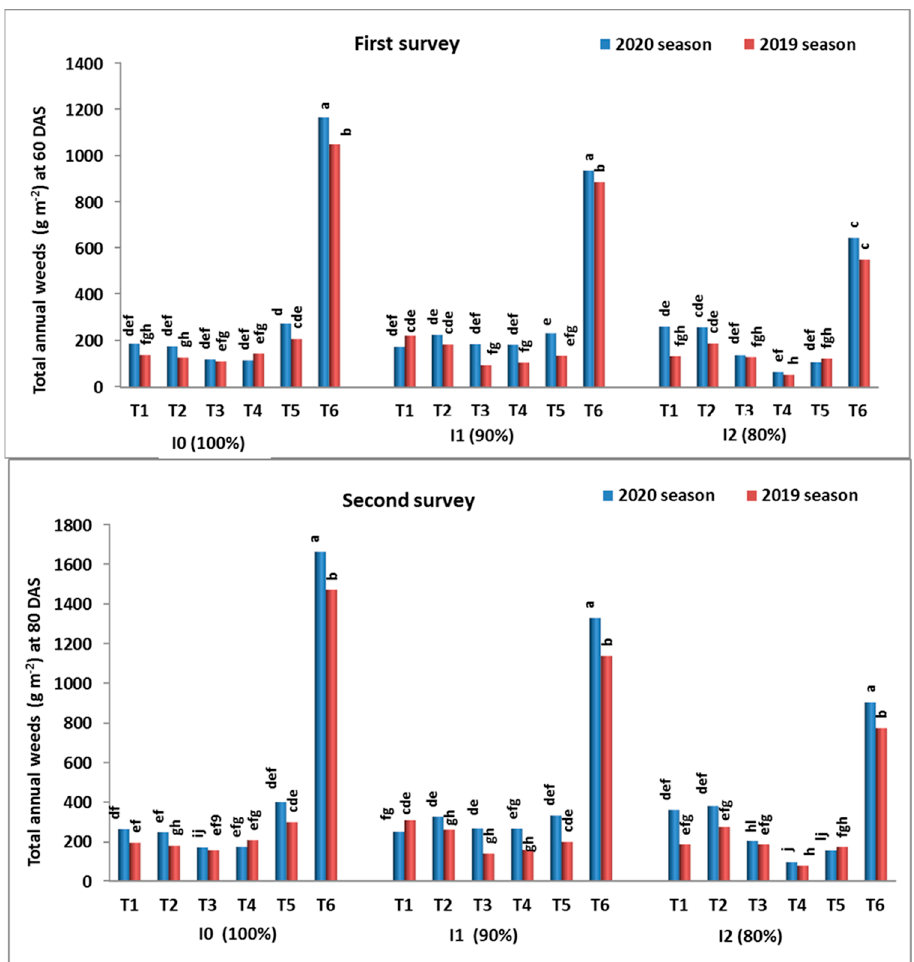
Figure 2. Effect of interactions between irrigation levels and weed control treatments on total annual weeds (g m − 2 ) in the first survey and second survey during the two seasons. I 0 : 100% irrigation level T 1 : pendimethalin CS 45.5% T 4 : imazethapyr WG 60%; I 1 : 90% irrigation level T 2 : oxyfluorfen EC 24% T 5 : hand-hoeing twice; I 2 : 80% irrigation level T 3 : bentazon AS 48% + clethodim EC 12.5% T 6 : untreated check. Different letters represent significant differences (0.05).